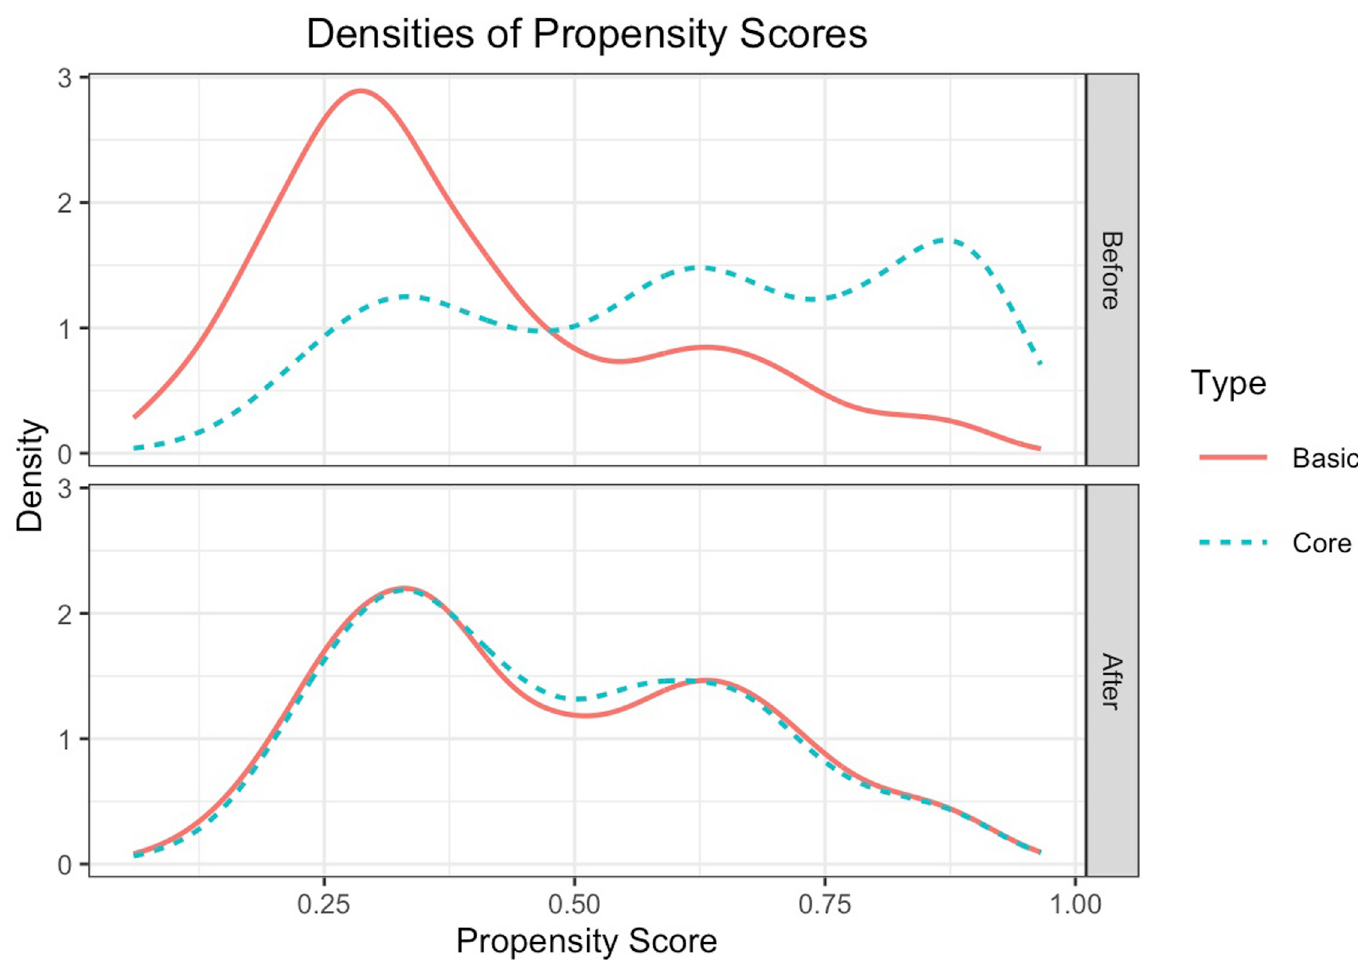
Fig 1. Distribution of the estimated propensity score by survey type in the original unmatched sample (top panel) and in the matched sample (bottom panel). Solid line corresponds to Basic survey. Dashed line corresponds to Core survey.